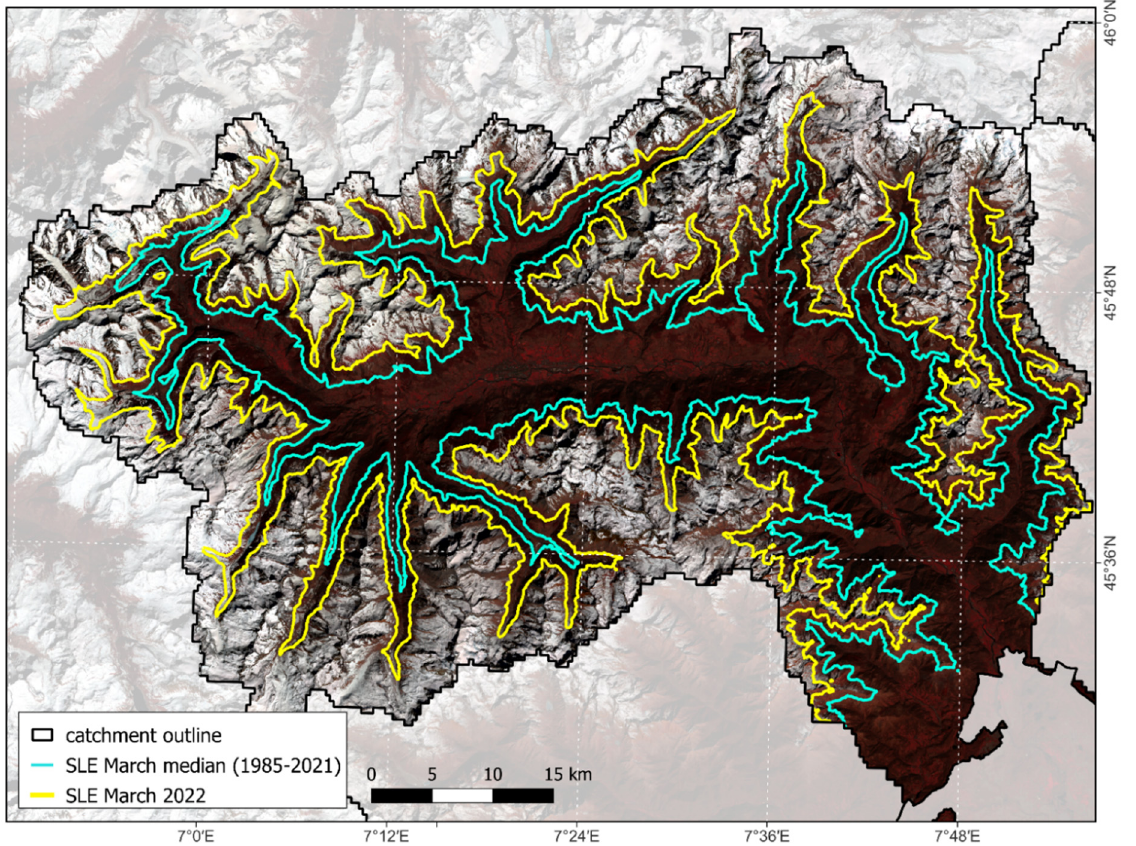
Figure 3. Location of the SLE in March 2022 (2125 m.a.s.l.) compared to the SLE median (1636